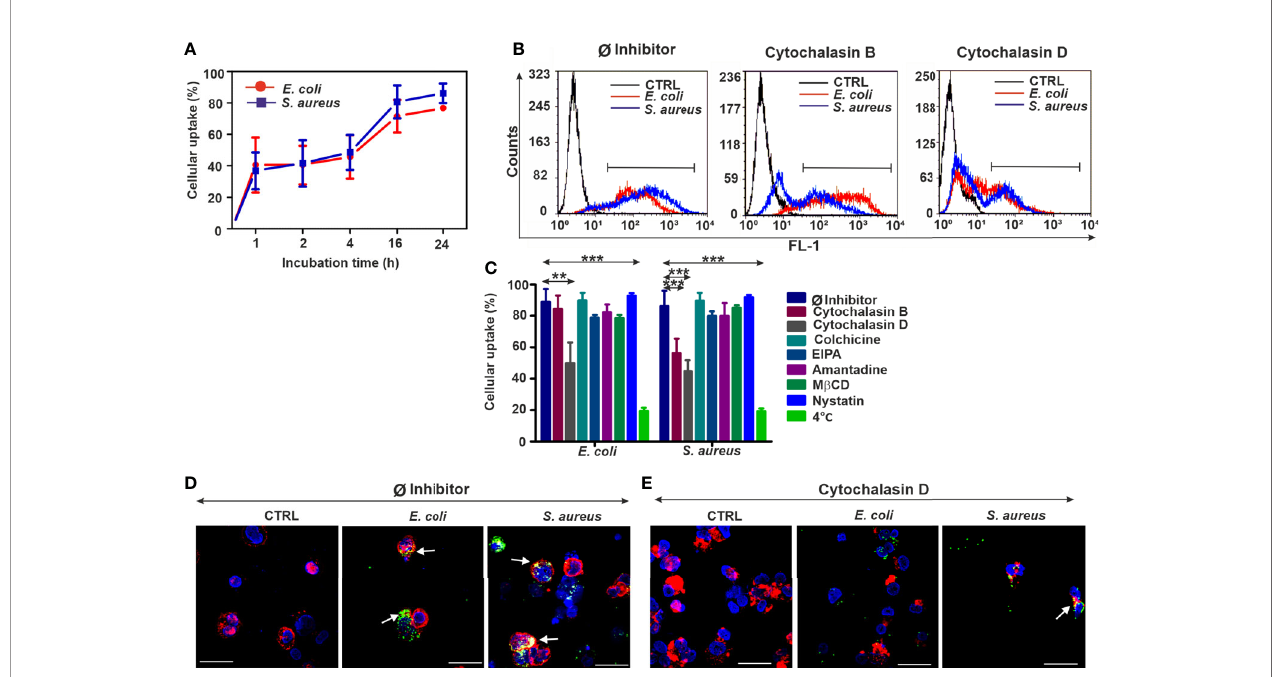
FIGURE 2 | Biased bacterial engulfment in diff. THP-1 cells upon endocytosis inhibition. (A) Kinetics of FITC- E. coli and FITC- S. aureus uptake by diff. THP-1 cells after 1, 2, 4, 16, and 24 h of incubation. (B) Representative fl ow cytometry histograms of diff. THP-1 cells after 24 h of bacteria uptake, without or with inhibitors (5 µM cytochalasin B/cytochalasin D). (C) Ef fi ciency of various endocytosis blockers on the bacterial engulfment in diff. THP-1 cells. The results are presented as mean ± SD of four replicates. Asterisks mark statistical signi fi cance (** p < 0.01, *** p < 0.001) between the Ø inhibitor control and various treatments. (D) Merged CLSM images of diff. THP-1 cells in the absence of endocytosis inhibitors or (E) in the presence of 5 µM cytochalasin D that demonstrate the changes in the actin cytoskeleton (red, CF568 Phalloidin) and inhibition of bacterial (green, FITC- E. coli and FITC- S. aureus ) uptake. Nuclear counterstaining was performed with DAPI (blue). Note the overlapping signal between engulfed bacteria and actin fi laments (arrows, D ). Scale bars: 50